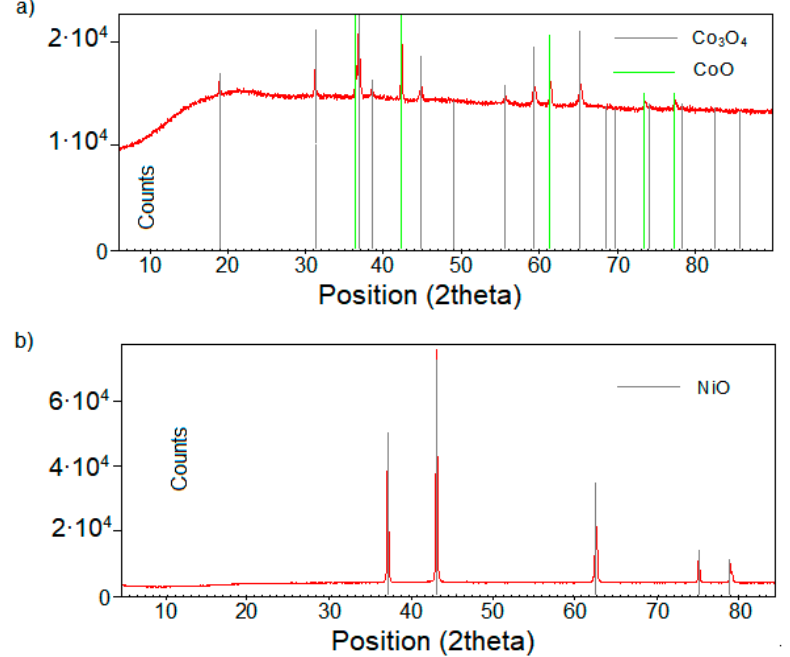
Figure 6. PXRD patterns of cobalt oxides ( a ) and ( b ) nickel oxide. Heating of 2 led to the formation of NiO, which perfectly fits with the reference data 04-006-1894. This nickel(II) oxide crystallized in the cubic crystal system with the Fm-3m space group and unit cell parameters: a = b = c = 4.1800 Å, Z = 4, and V = 73.03 Å 3